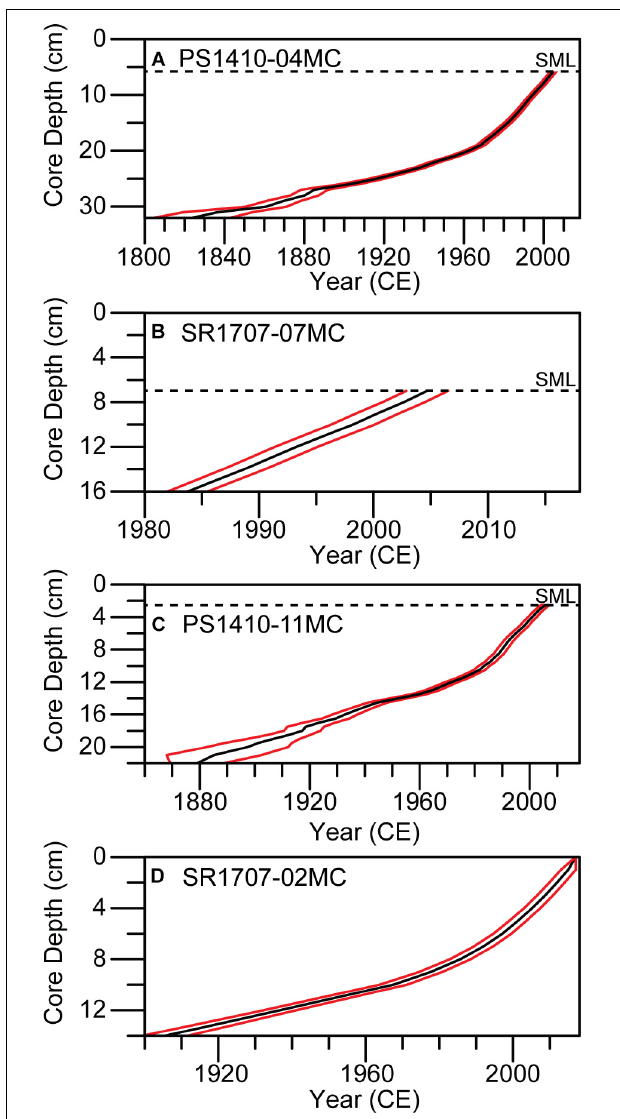
FIGURE 8 | Age-depth models for all the multicores: (A) PS1410-04MC, (B) SR1707-07MC, (C) PS1410-11MC, and (D) SR1707-02MC. The ages were determined from the 210 Pb xs data using the Constant Rate of Supply model. The black line represents the modeled age with the red lines constraining the age uncertainty determined by propagating errors from the counting statistics. Ages were plotted below the Surface Mixed Layer (SML – dashed horizontal line) where